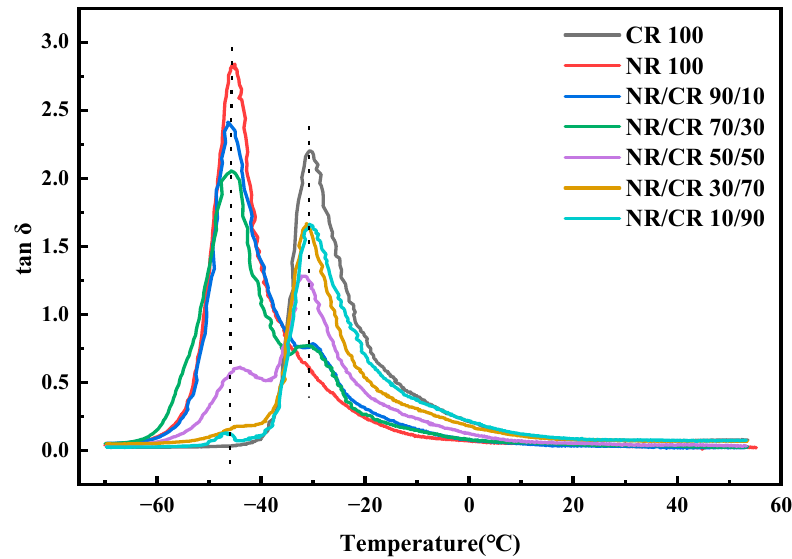
Figure 8. Curves of tan δ versus temperature for the NR/CR blends with different mass ratios.